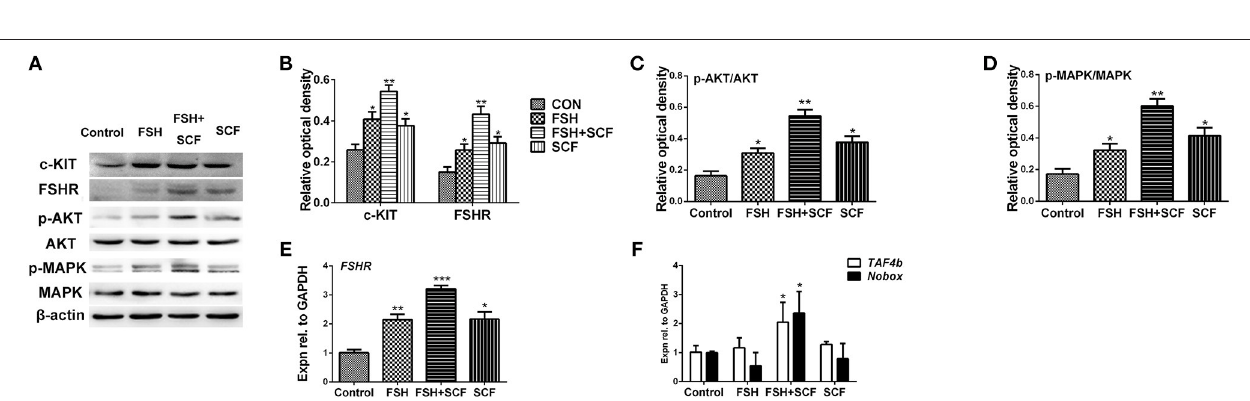
FIGURE 5 | Effects of FSH treatment on KIT signaling in vivo . (A) Western blot and gray analysis of FSHR positive and negative controls in the 6-day-old chicken and mouse ovaries. Western blot and gray analysis indicate that FSH significantly promoted expression of FSHR (B,C) , c-KIT (B,D) , p-AKT/AKT (E,F) , p-MAPK/MAPK (E,G) . T -tests were used to determine statistically significant differences. The values are the mean ± SEM of six experiments. Asterisks indicate significant differences (* P < 0.05, ** P < 0.01).